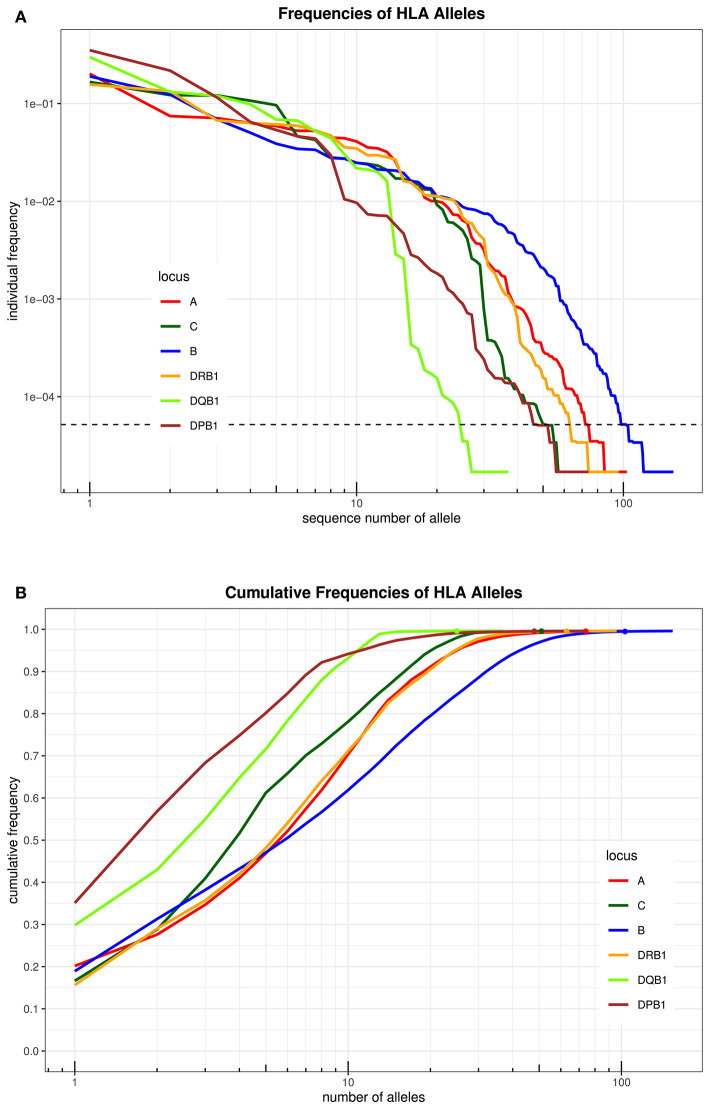
(A) The alleles of each locus are ordered by descending frequency on the x-axis, and the curve shows their frequency. Both axes are in logarithmic scale. The dotted horizontal line shows the frequency corresponding to three copies in the sample. (B) For each number (n) on the x-axis in logarithmic scale, the curve depicts the cumulative frequency of the set of the n most frequent alleles of each locus. The closer a curve is to the left and top, the more homogeneous a population is for this locus. The dots on each curve mark the cumulative frequency of all alleles seen at least three times in the sample.